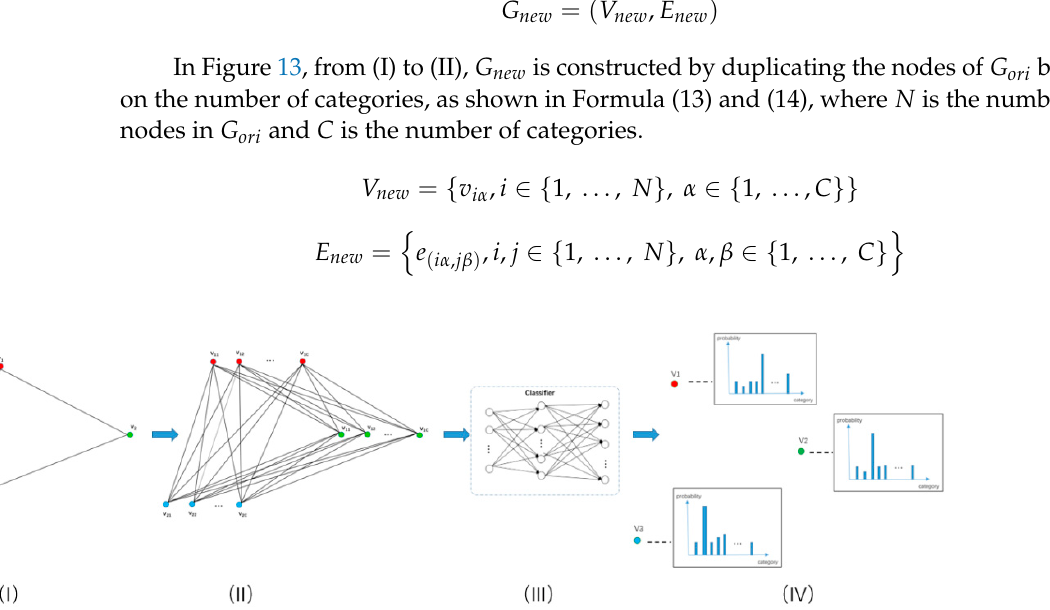
Figure 13. Process of prior knowledge embedding. ( I ) is the structure of the original graph G ori ; ( II ) is the structure of the new graph G new with prior knowledge embedding, as expressed in Formula (12); ( III ) is a classifier for classifying nodes, which is a simple multi-layer perceptron (MLP). ( IV ) is the restoration of G new after classifying